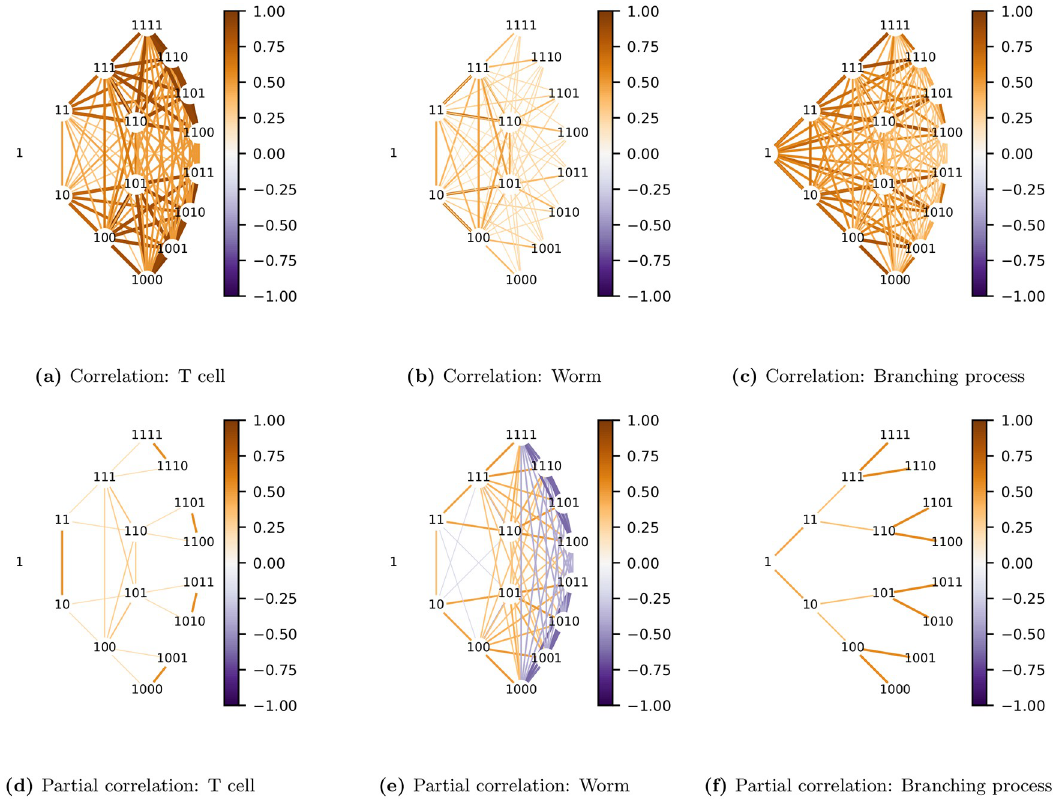
Fig 9. Lineage correlation maps. These are undirected graphs in the original variables (shown as binary numbers). Each generation is arranged in an arc centered on the root node. The color of edges in each graph corresponds to the correlation (top row) or partial correlation (bottom row) between pairs of lineal positions. To avoid clutter, only the first 4 generations are shown. Note how the graph (f) of partial correlations for the simulated branching process, where daughters are conditionally uncorrelated, is a binary tree. This is not the case for the real